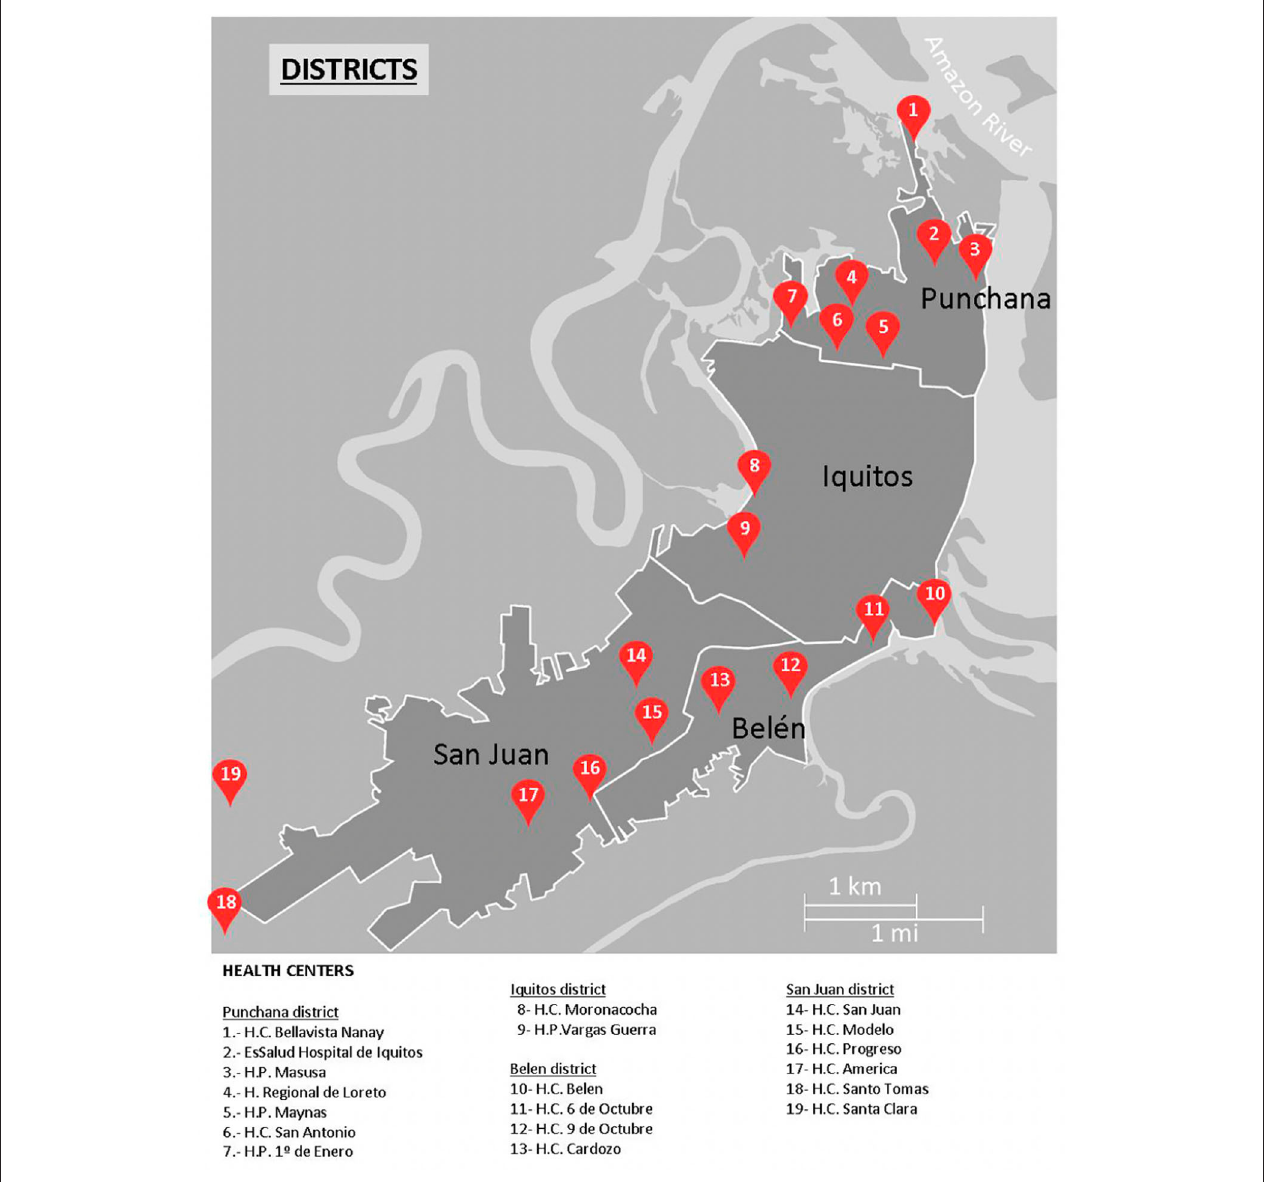
FIGURE 1 | Health centers in Iquitos city and surrounding